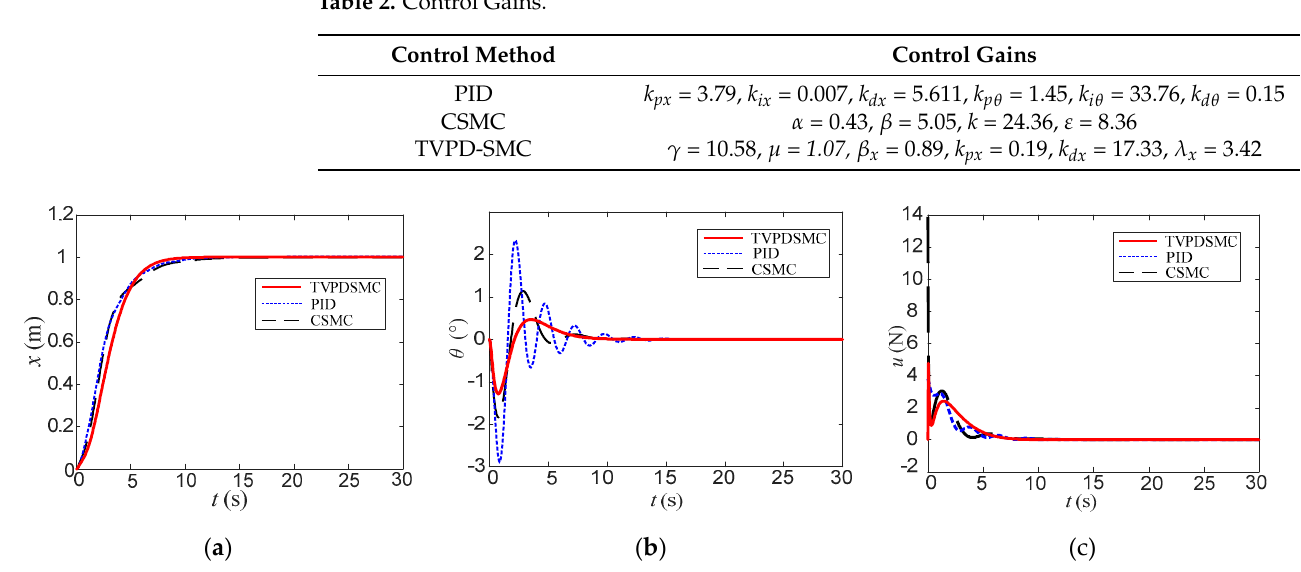
( c ) Figure 5. Simulation 3: System state variable response curve. ( a ) Trolley Displacement; ( b ) Payload Swing angle; ( c ) Driving force. It can be seen from Figure 5 that under the conditions of simulation 3, the method proposed in this paper can quickly return to the steady state after the end of the disturb- ance, the trolley motion curve is smoother, and the positioning performance is almost